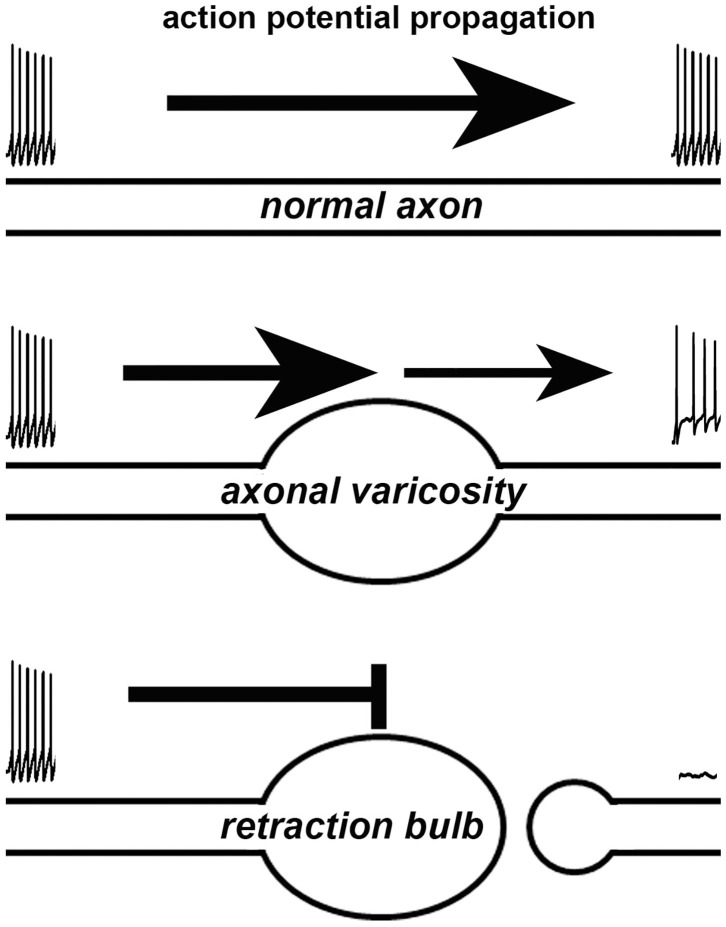
Effects of an axonal varicosity or a terminal bulb on action potential propagation along an axon. Action potentials propagate along a normal axon with high fidelity (top). Altered waveform, reduced frequency and even failure of action potentials can be induced by axonal varicosity (middle). A terminal bulb indicates a broken axon, which no longer allows action potentials to travel through.